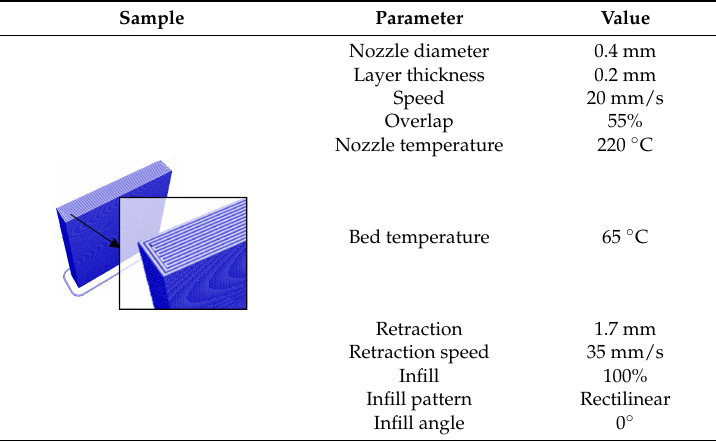
Table 1. Values of the most characteristics fixed parameters.